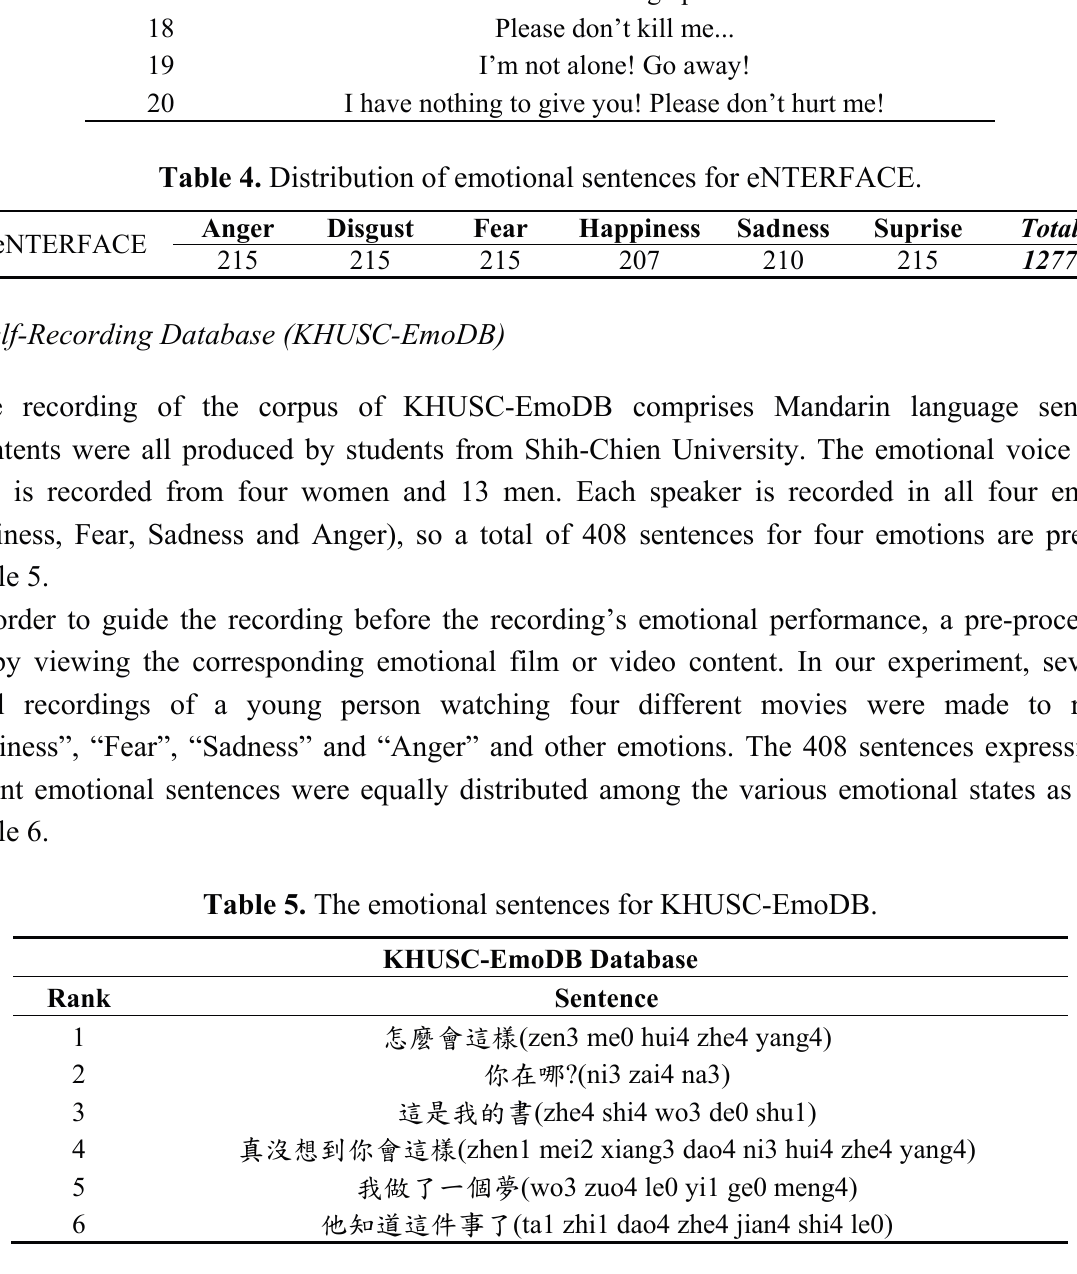
Table 6. Distribution of emotion for